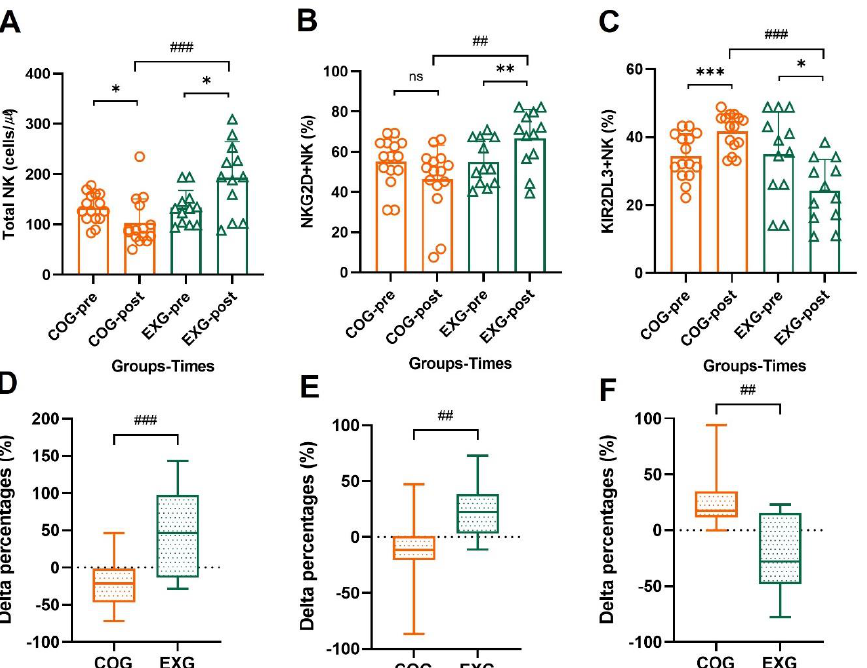
Figure 7. NKG 2 D+NK and KIR 2 DL 3 +NK receptors of total NK cells are improved in the ovarian cancer survivors after 12 weeks of aerobic and resistance exercise. ( A ) Total NK cells’ absolute values in the control group (COG) and in the exercise group (EXG). ( B ) NKG 2 D+NK receptor percentages of total NK cells’ absolute values in the COG and EXG. ( C ) KIR 2 DL 3 +NK receptor percentages of total NK cells’ absolute values in the COG and EXG. ( D ) Percentages of total NK cells analyzed as ∆ % in both groups. ( E ) Percentages of NKG 2 D+NK receptor analyzed as ∆ % in both groups. ( F ) Percentages of KIR 2 DL 3 +NK receptor analyzed as ∆ % in both groups. All data are represented as means ± SD. p -values were calculated by Student’s t test or Mann–Whitney U test. For ( A ) to ( F ), these tests were performed independently at each time point; ## p < 0.01 and ### p < 0.001. p -values were calculated by Student’s t test or Wilcoxon signed rank test. For ( A ) to ( C ), these tests were performed dependently at each time point; ns: p > 0.05, * p < 0.05, ** p < 0.01, and *** p < 0.001.